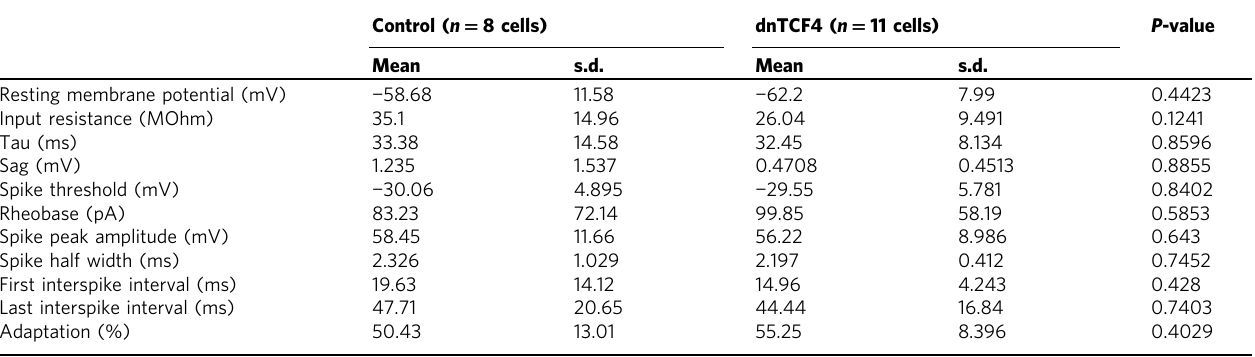
Table 1 Intrinsic electrophysiological properties of layer 2/3 neurons at P14 Control ( n = 8 cells)